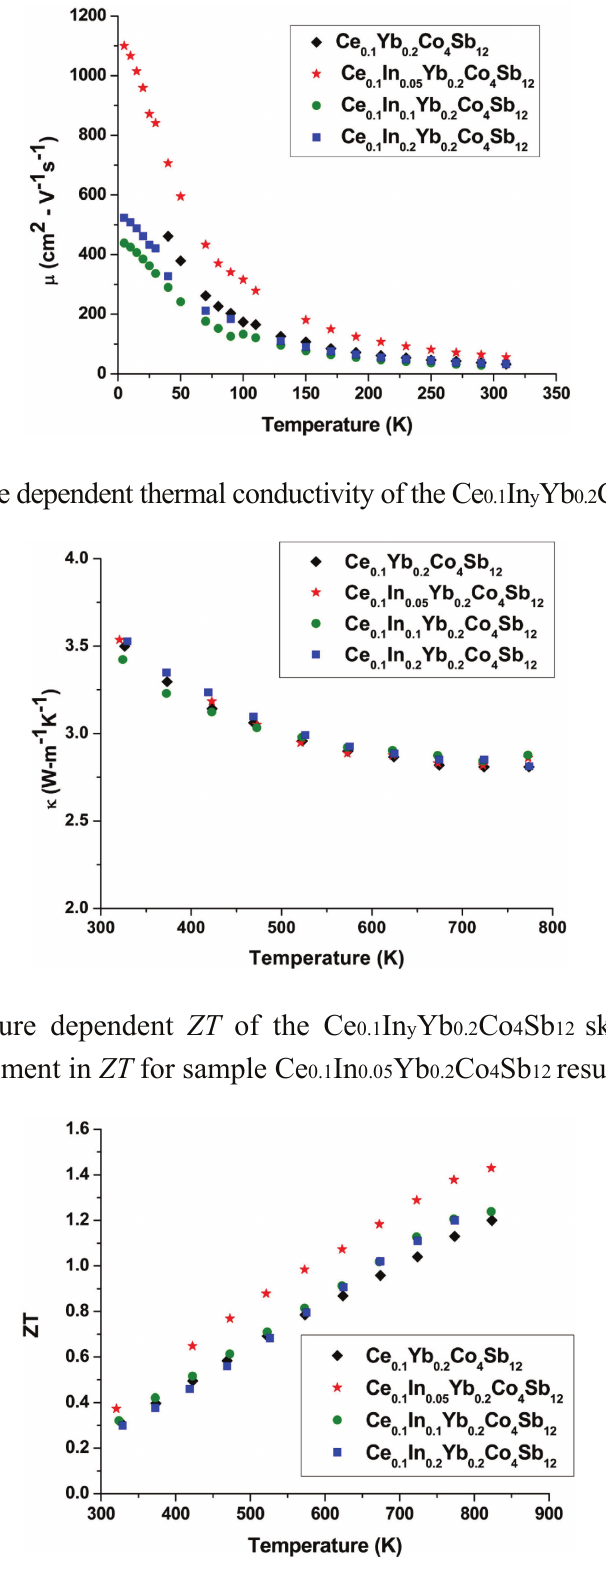
Figure 7. Temperature dependent carrier mobility of the Ce 0.1 In y Yb 0.2 Co 4 Sb 12 skutterudites with Ce 0.1 In 0.05 Yb 0.2 Co 4 Sb 12 having the most enhanced mobility and thus higher electrical conductivity.